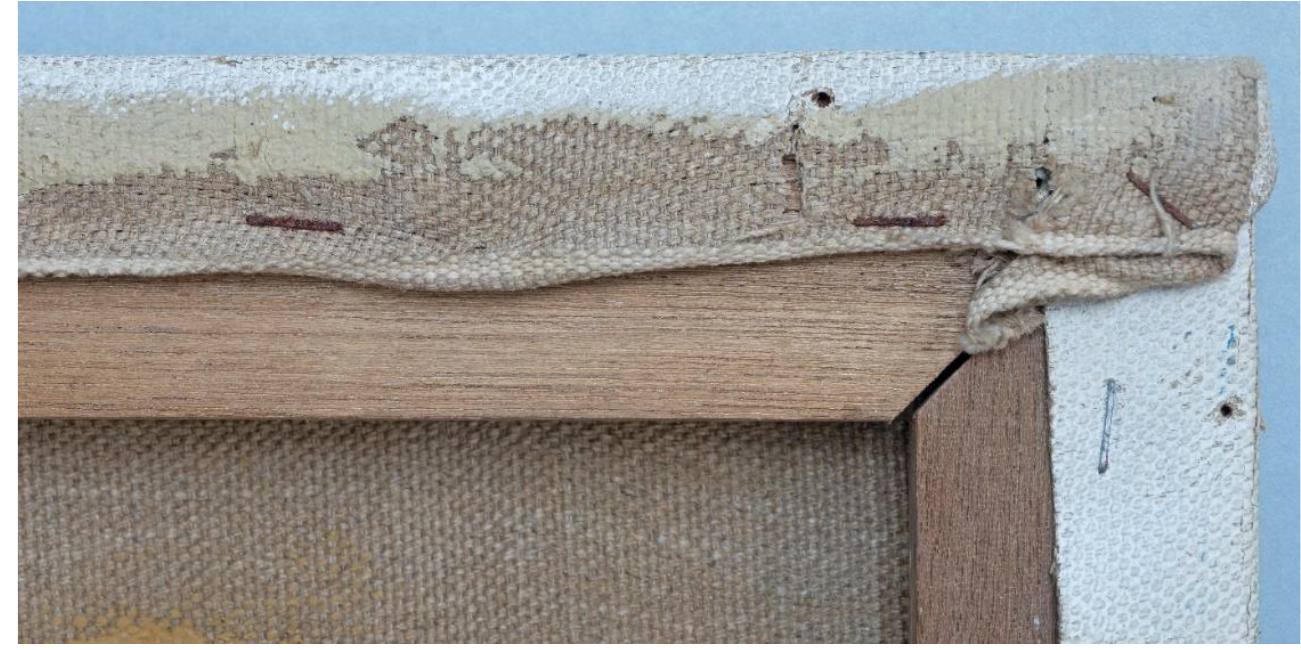
Figure 8. Close-up showing the uneven ground coverage found on the tacking margin of Mountains , 1991. Table 3. Overview of the ground characteristics of the investigated paintings.